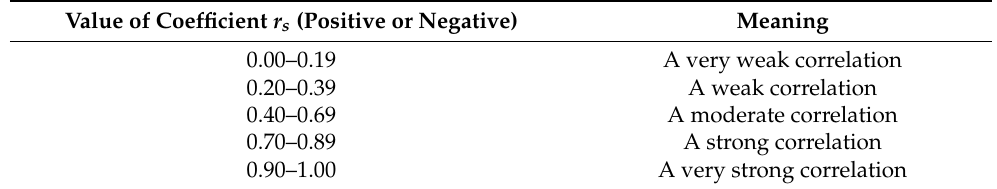
Table 3. Spearman correlation coefficient value and interpretation.